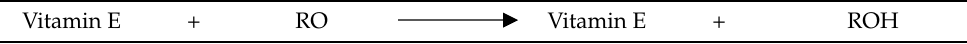
Table 1. The mechanism of the quenching of singlet oxygen by β -carotene. Table 2. Vitamin E reaction with oxygen free radicals.